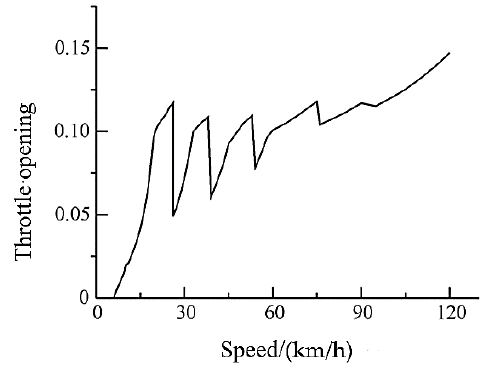
Figure 3. Throttle opening–speed curve.